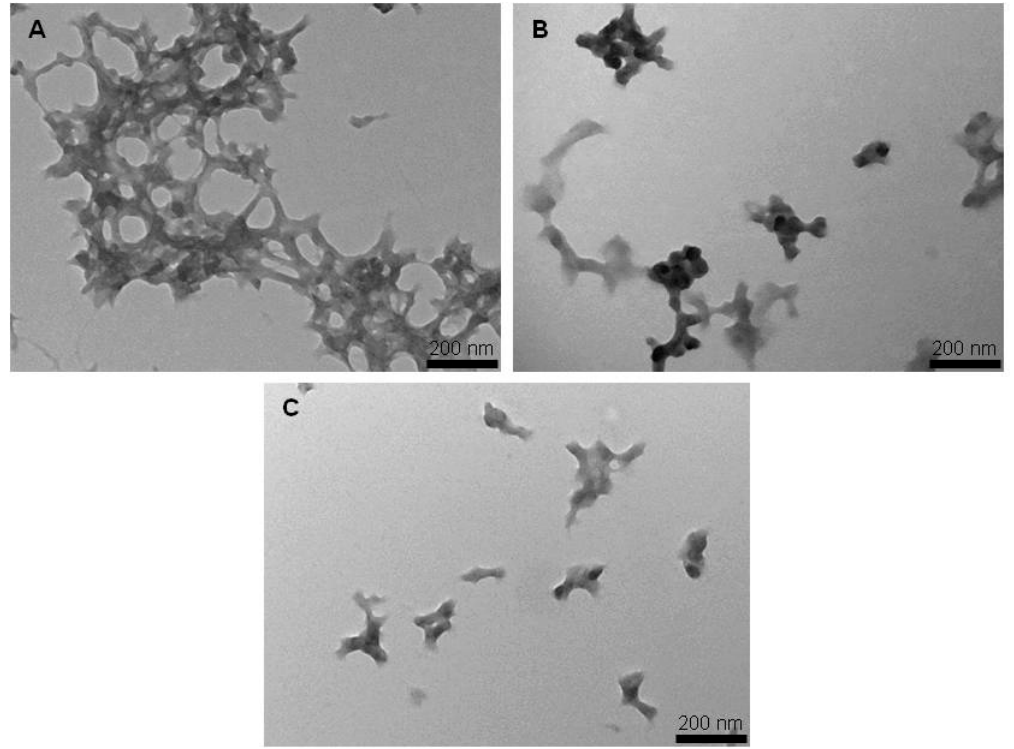
Figure 2. Transmission Electron Microscopy images of: ( A ) silk fibroin nanoparticles; ( B ) curcumin-loaded silk fibroin nanoparticles synthesized by physical adsorption; and ( C ) curcumin-loaded silk fibroin nanoparticles synthesized by coprecipitation (59,000×).